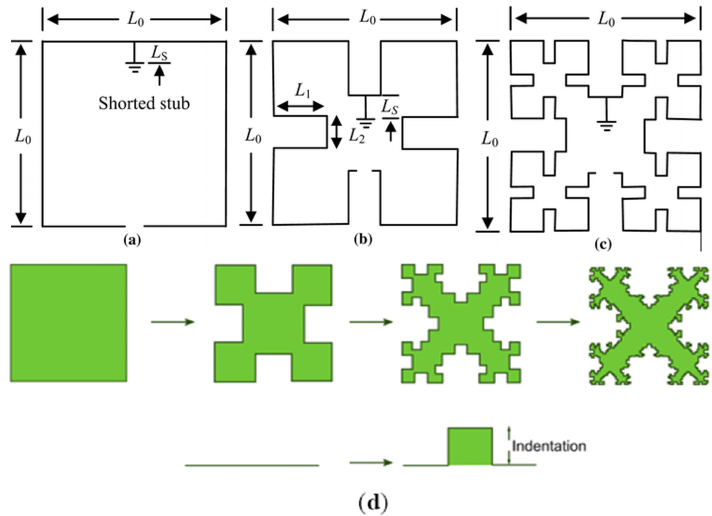
Figure 1. A drawing with the four iterations made ( a – d ), starting from the Minkowski initiator. ( a ) the initial start (square ring); ( b ) the 1st iteration; ( c ) the 2nd iteration; ( d ) the initial start (square ring) plus the first three iterations.